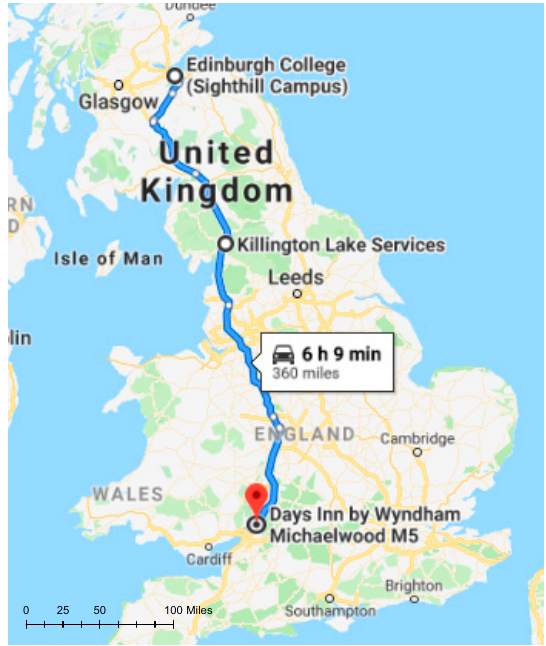
Figure 4. Long-range route (Google Maps, 2018).